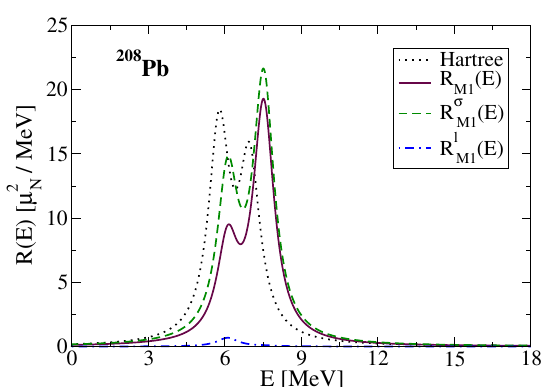
Figure 1. The M1 transition strength distributions for 208 Pb, in- cluding full response R M1 (E), spin response R σ sponse R (cid:96) (E), and unperturbed (Hartree) response M1